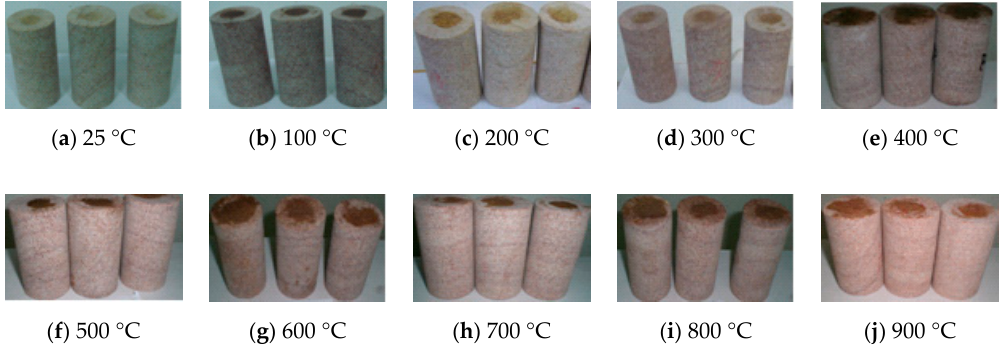
Figure 1. Group A samples at different temperature.